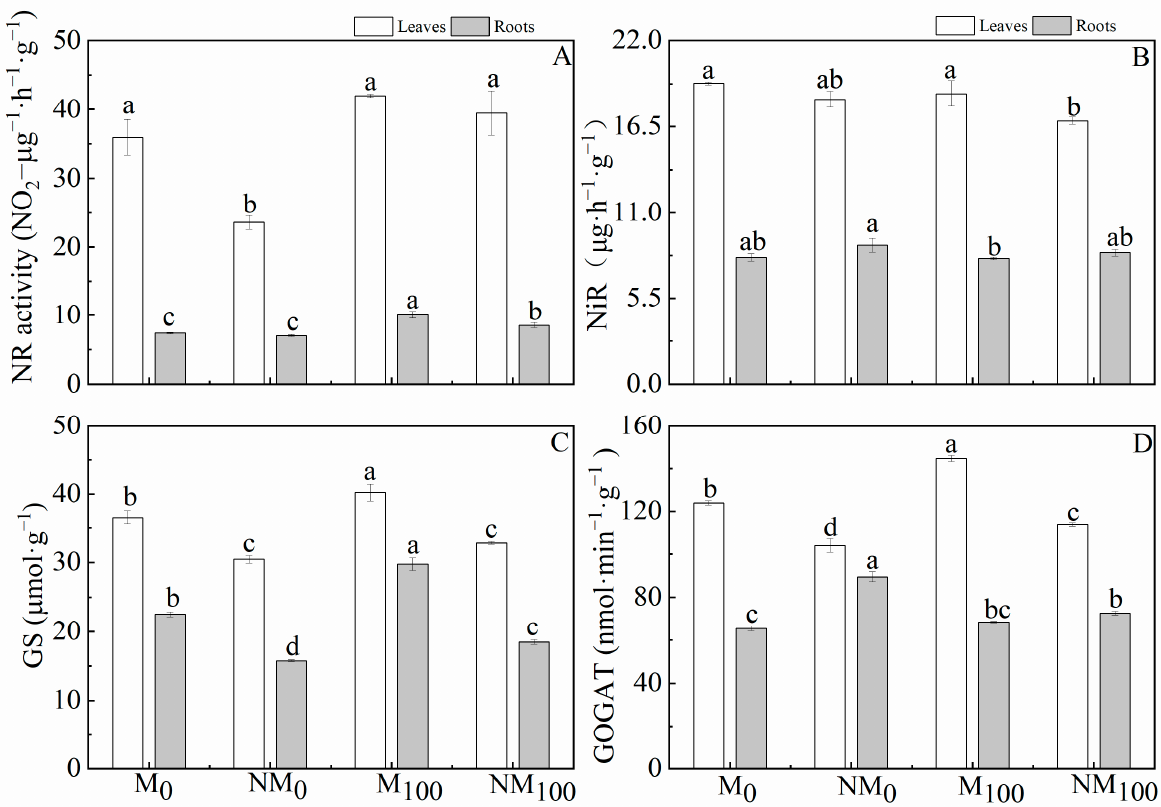
Figure 4. Changes in the activities of nitrate reductase (NR, ( A )), nitrite reductase (NiR, ( B )), glutamine synthetase (GS, ( C )), and glutamate synthase (GOGAT, ( D )) in leaves and roots of Neva irrigated with or without magnetized water following exposure to 0 or 100 µ mol · L − 1 cadmium stress. Values are the means ± SE of at least three replicates. Different lowercase letters indicate significant differences among the four treatments at the 0.05 level in leaves and roots.